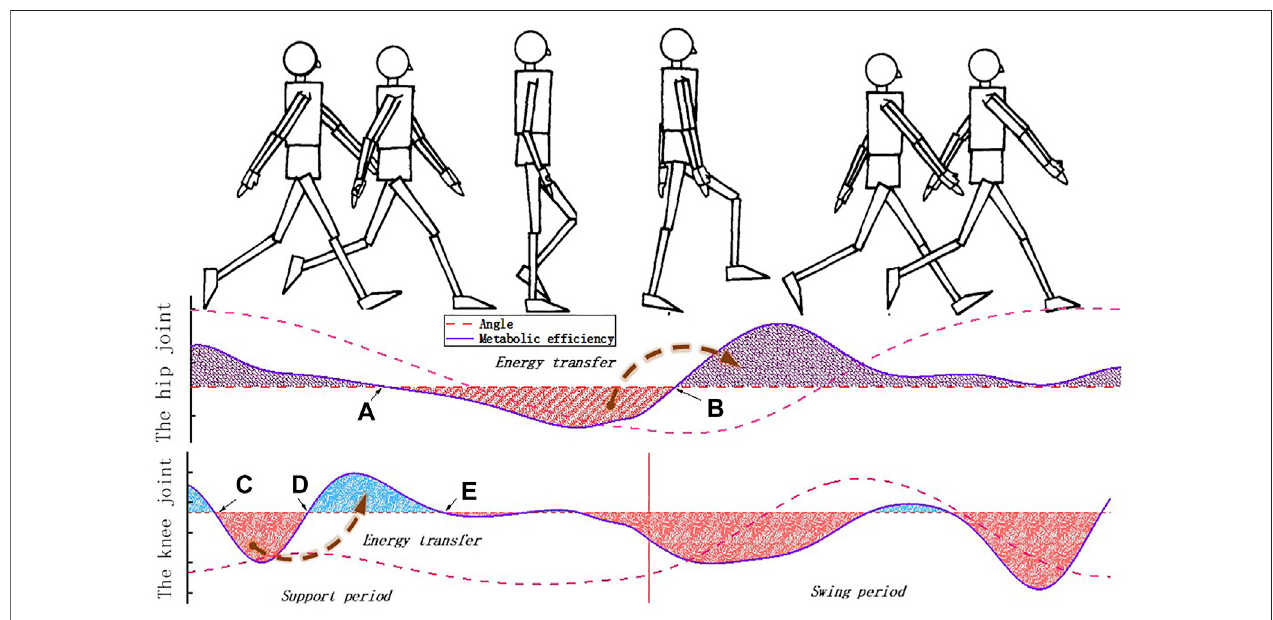
FIGURE 2 | Movement characteristics of the lower limbs of the human